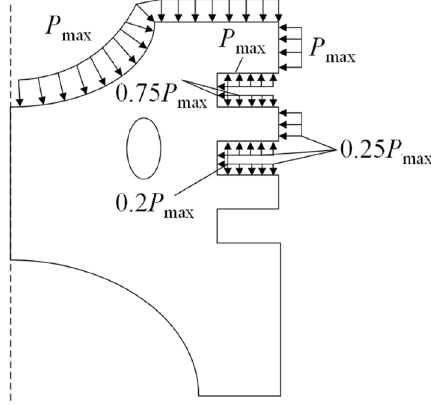
Figure 6. Gas pressure of the